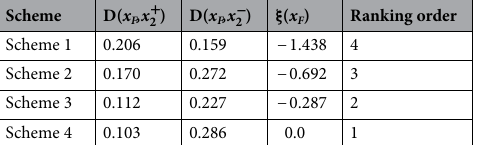
Table 13. Ranking of smart logistics transport vehicle concept design options.